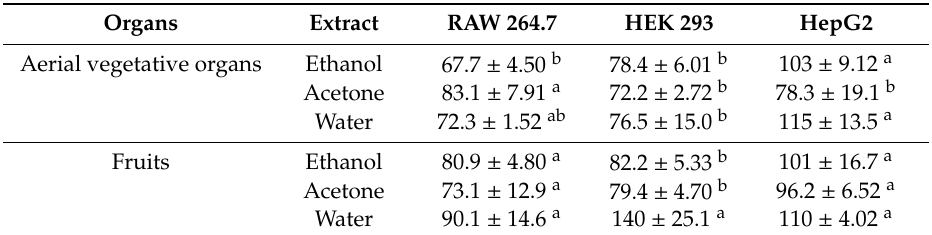
Table 1. E ff ect of the application of 100 µ g / mL of food grade extracts prepared from aerial vegetative organs and fruits of sea rocket ( Cakile maritima ) during 72 h on the viability of RAW 264.7 (murine macrophages), HEK 293 (human embryonic kidney), and HepG2 (human hepatocellular carcinoma) cell lines. Organs Extract RAW 264.7 HEK 293 HepG2 Aerial vegetative